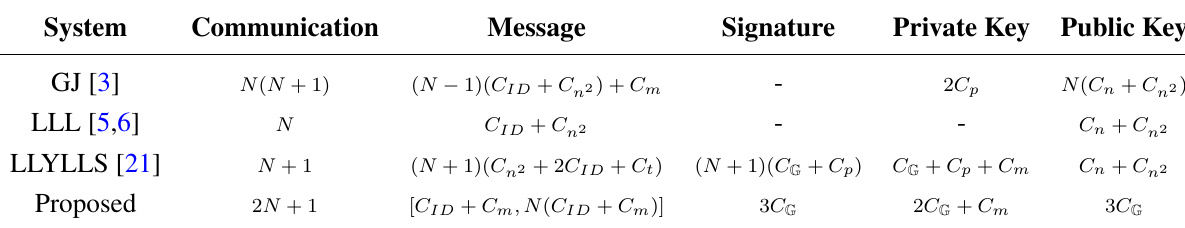
Table 2. Efficiency